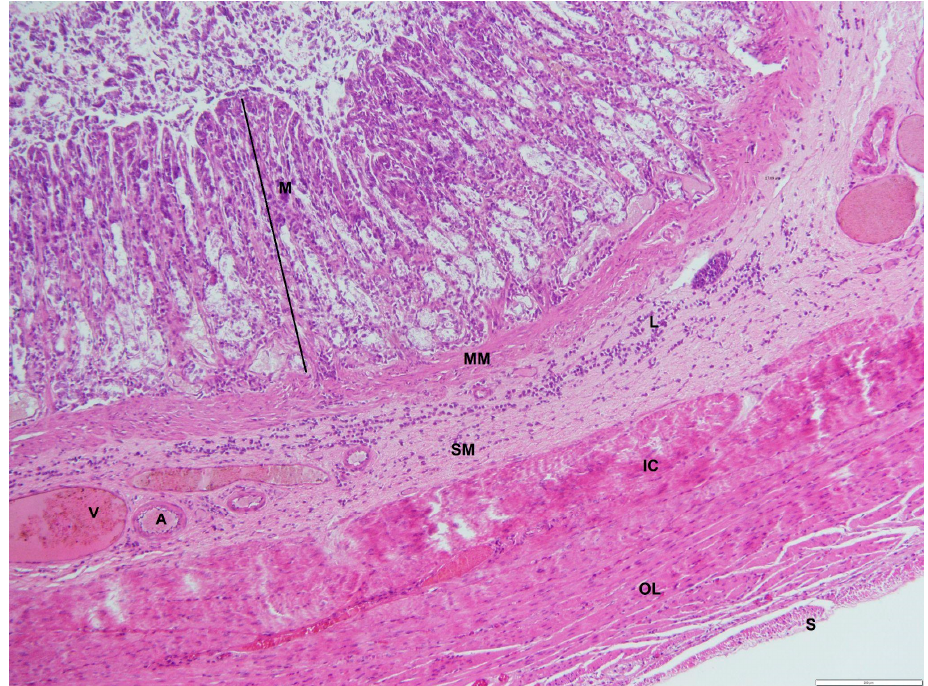
Figure 7. Photomicrograph of a cross-section through the fundic region of an adult male D. leporina . H&Ex200. M—mucosa; MM—muscularis mucosa; SM—submucosa; L—lymphocyte infiltration; A—arteriole; V-venule; IC—inner circular layer; OL—outer longitudinal layer; S—Serosa.